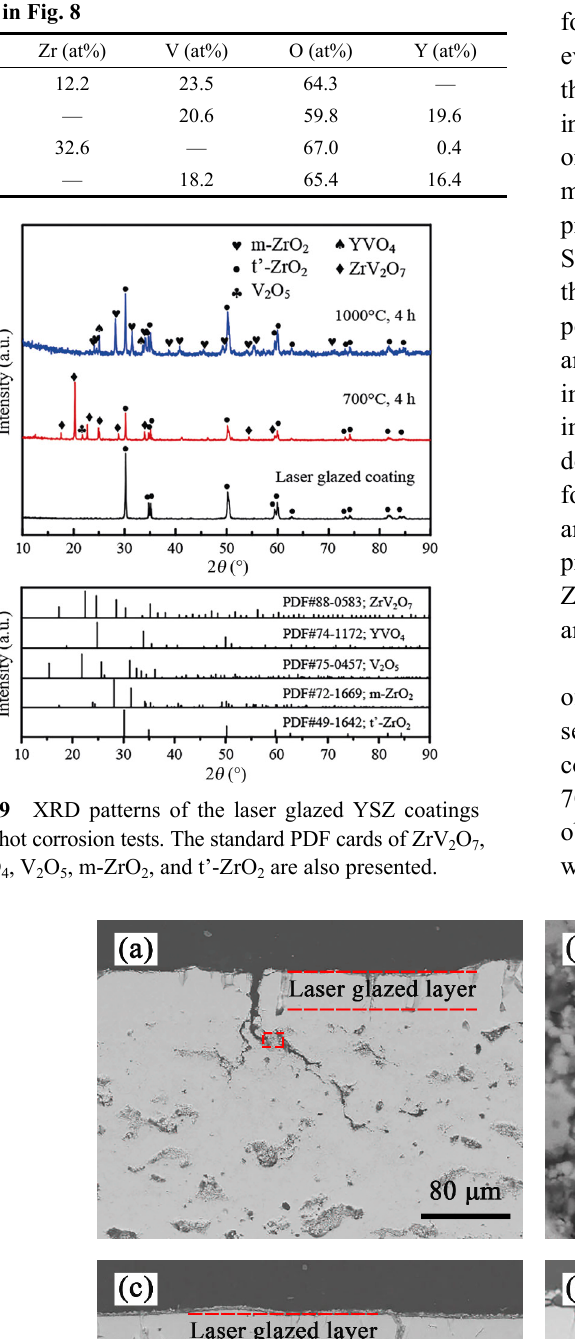
Table 4 Chemical compositions of the different regions